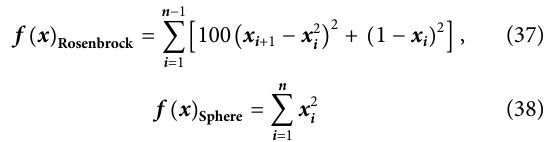
FIGURE 1 | Plots of the ratio of computational cost β vs. n 2 /m , computed using Eq. 35 by fi xing N DIQ (cid:2) N MIL (cid:2) 0 in (A) and N DIQ (cid:2) N MIL (cid:2) 10 in (B)